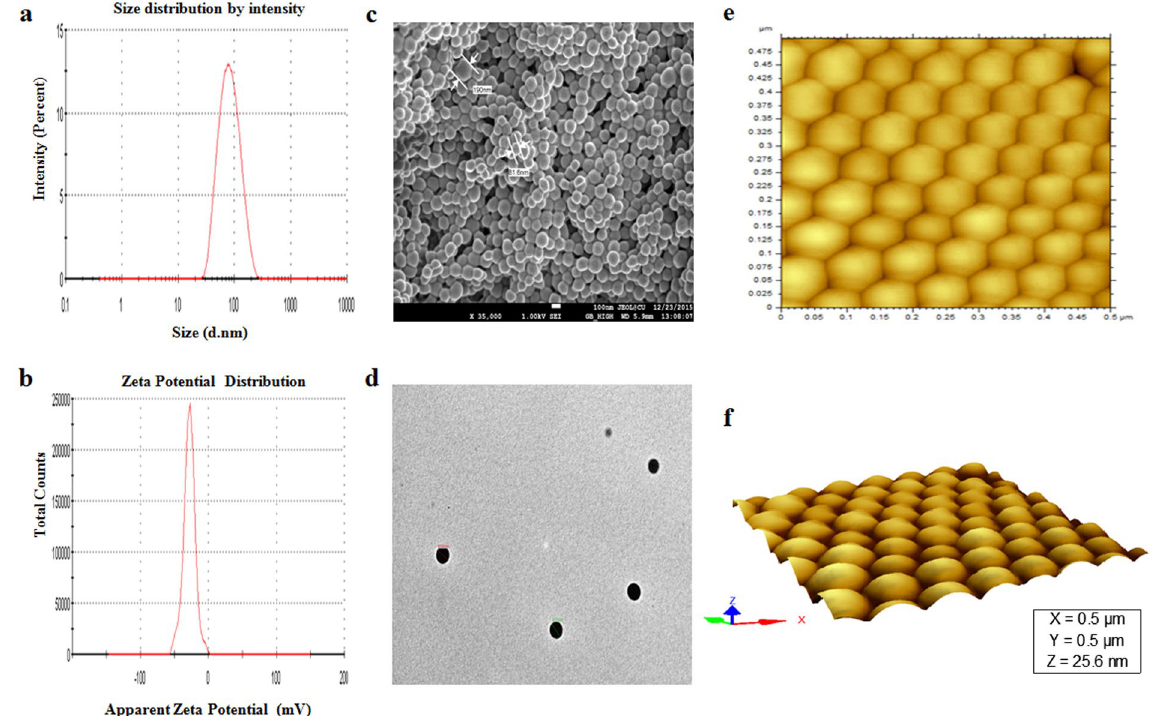
Figure 1. Particle size distribution, zeta potential measurement profile and microscopic imaging of GAR-NPs. ( a ) Particle size distribution pattern, ( b ) zeta potential distribution profile, ( c ) FESEM image, ( d ) TEM image, ( e ) AFM image and ( f ) three dimensional view of AFM